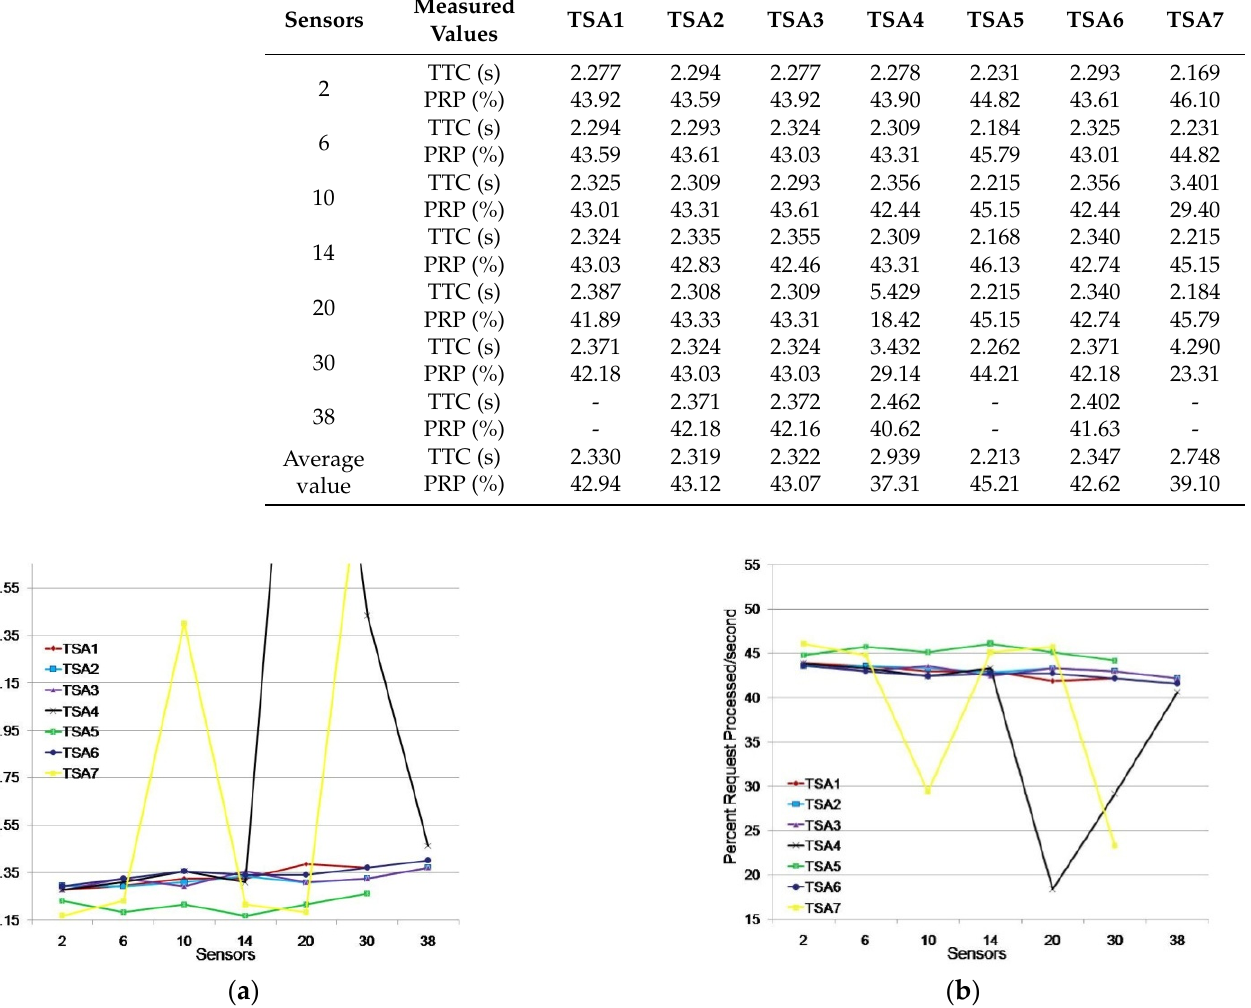
Table 4. Results of TTC and PRP timestamp issuing of TSAs in an environment with two